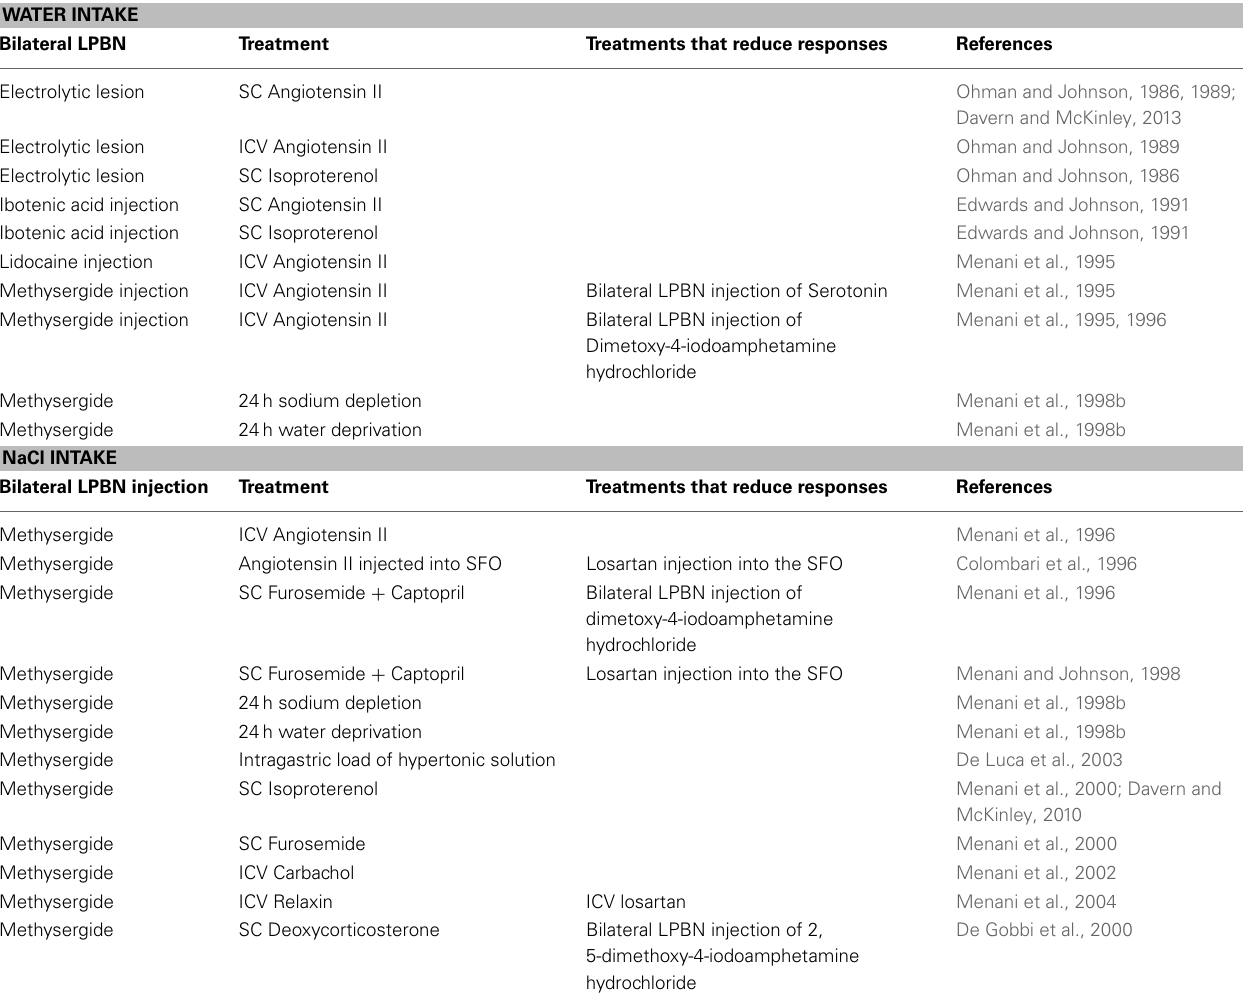
Table 1 | Table Summary of studies examining actions in the LPBN combined with treatments suggesting serotonin receptors in the LPBN are involved in regulating water and salt